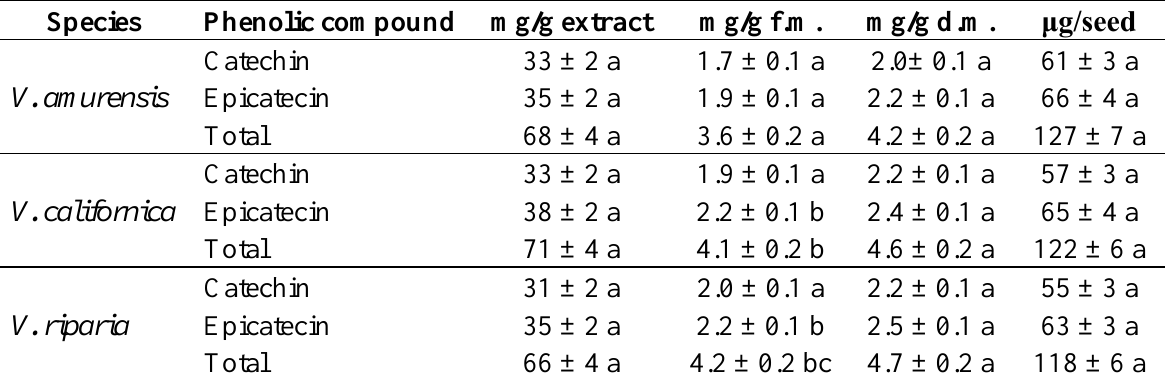
Table 3. Content of catechins in the methanolic extracts and seeds.